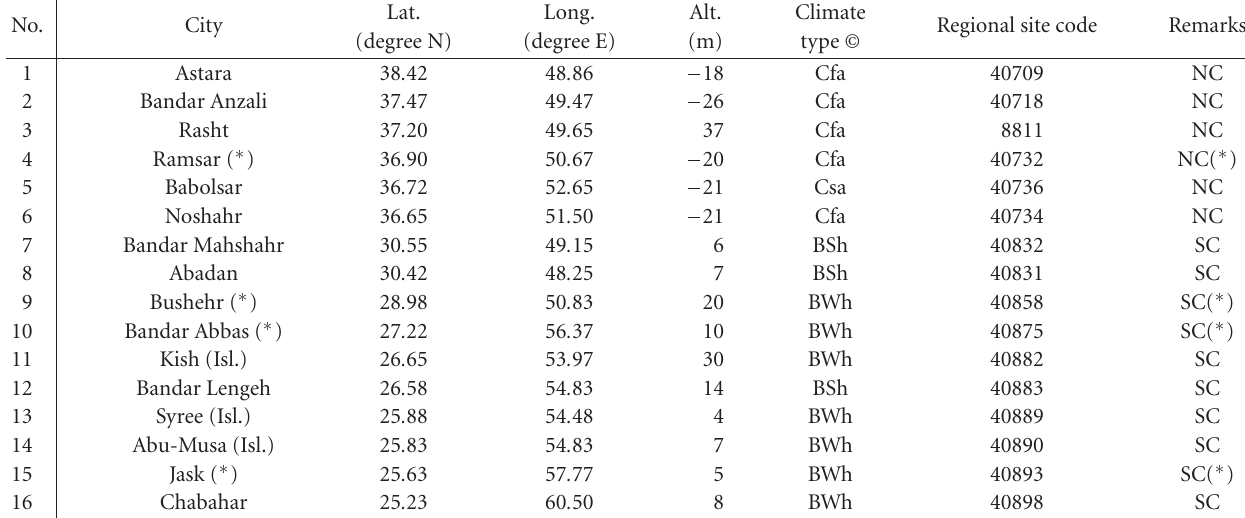
Table 1: Geographical information of the northern and the southern coastal cities (IRAN). Lat. No. City